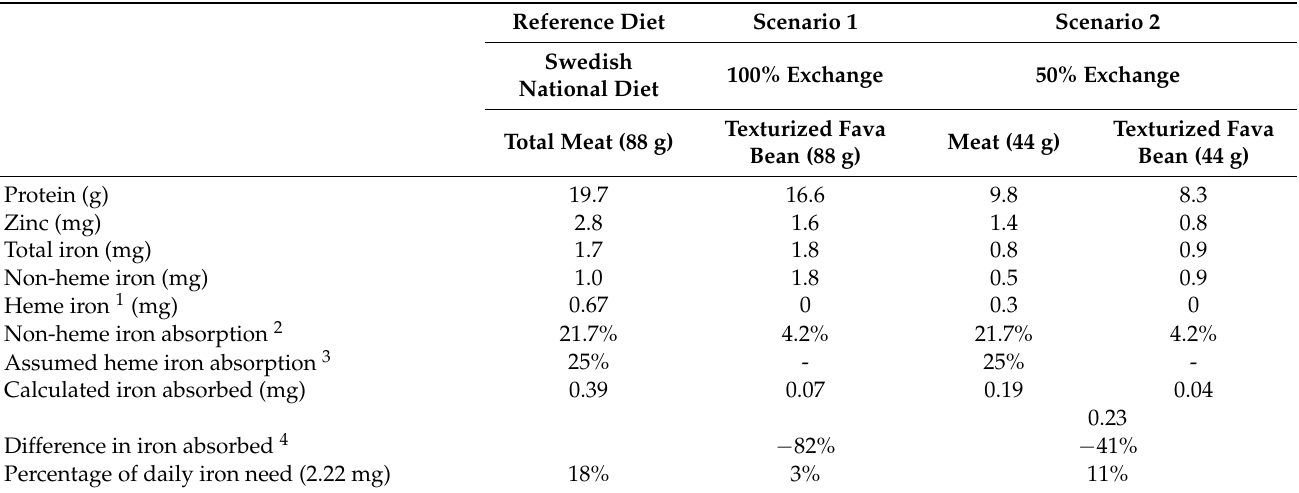
Figure 1. Box plot of adjusted and unadjusted non-heme iron absorption from texturized fava bean meal, cod-protein meal, and beef-protein meal. Absorption of texturized fava protein is based on combined data from Study 1 and Study 2. Grey boxes represent data adjusted to a 40% reference dose absorption; white boxes represent unadjusted data. Adjusted and unadjusted data based on combined data from absorption quota and WBC was significantly ( p < 0.05) different between each of the three meals, analyzed by Mann–Whitney U test. Table 4. Scenario calculations on the effects of absorbed iron when 100%, and 50% of the total meat intake is exchanged to texturized fava bean